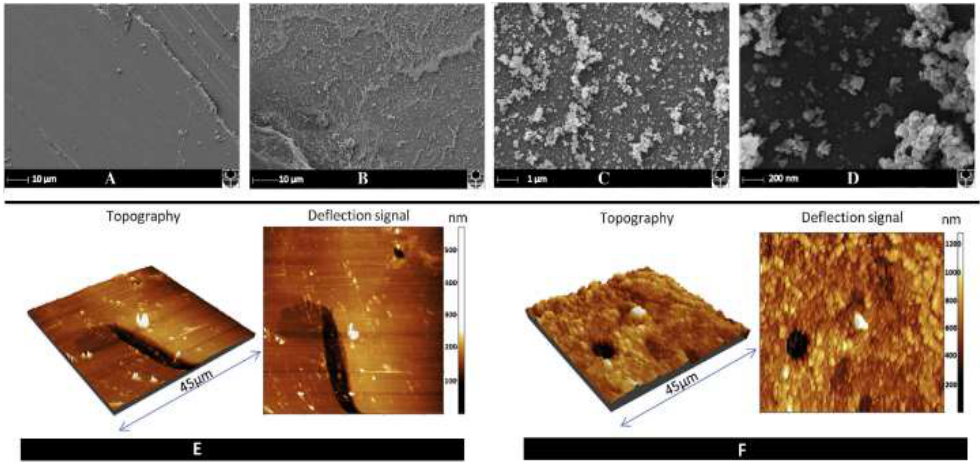
Figure 3. SEM and atomic force microscopy image of calcite surface. Calcite surface before ( A ) and after ( B ) nanofluid treatment; ( C ) High resolution; ( D ) Max resolution; Topography picture before ( E ) and after ( F ) nanofluid treatment. Reproduced with permission from reference [167]. Copyright 2016 Elsevier.